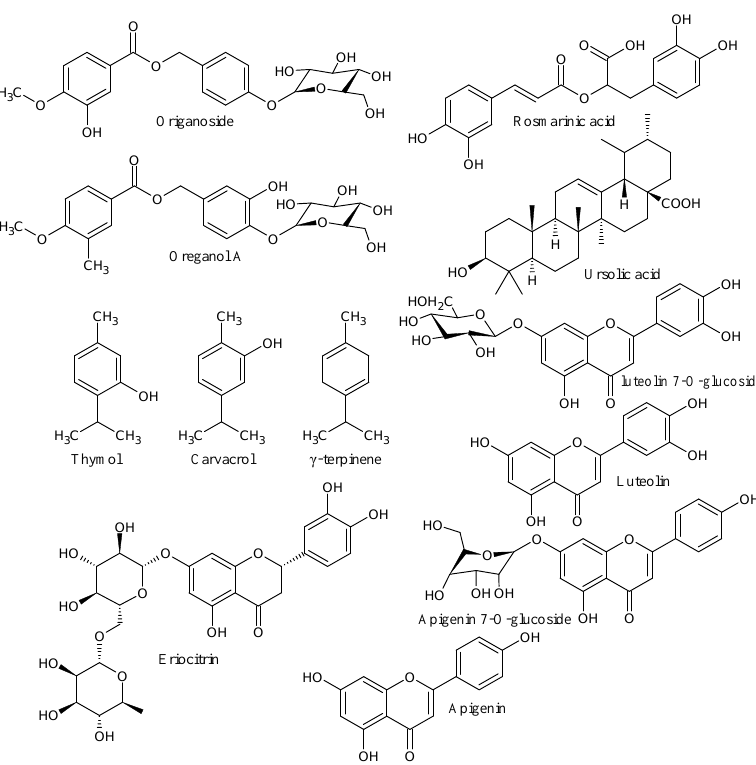
Pharmaceutics 2021 , 13 , 1743 Figure 1. Chemical constituents present in the Origanum vulgare extract. Figure 1. Chemical constituents present in the Origanum vulgare extract . Plant extracts are used as a replacement for stabilizing and reducing agents in the presence of several major bio components, such as terpenoids, alkaloids, phenolic agents, tannins, proteins, amino acids, polysaccharides, enzymes, vitamins, and saponins. This study presents a simple, green, and low-cost method for making stable and pure ZnO NPs using Origanum vulgare extract, free of chemical additives, such as bases, acids, and or- ganic solvents, which are commonly used in conventional chemical methods. Figure 2 shows a schematic representation of the ZnO NPs green synthesis process. The current study was validated by performing spectroscopic and microscopic characterizations of prepared ZnO nanoparticles.